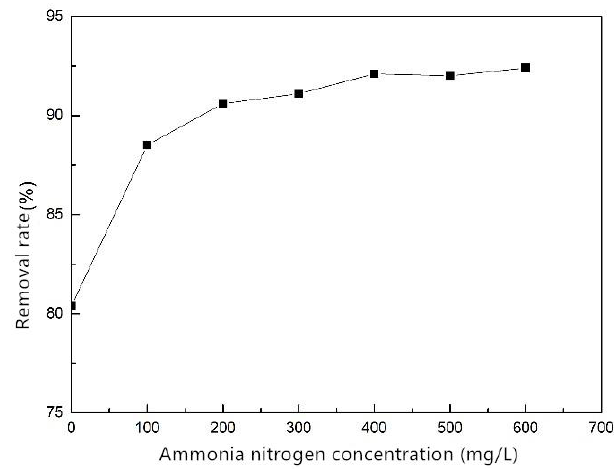
Figure 7. E ff ect of ammonium on phosphorus removal of ZSFB composite Figure 7. Effect of ammonium on phosphorus removal of ZSFB composite fiber.